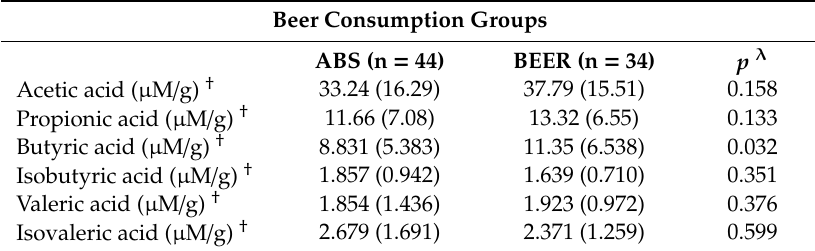
Table 5. SCFA concentration in moderate beer consumers and